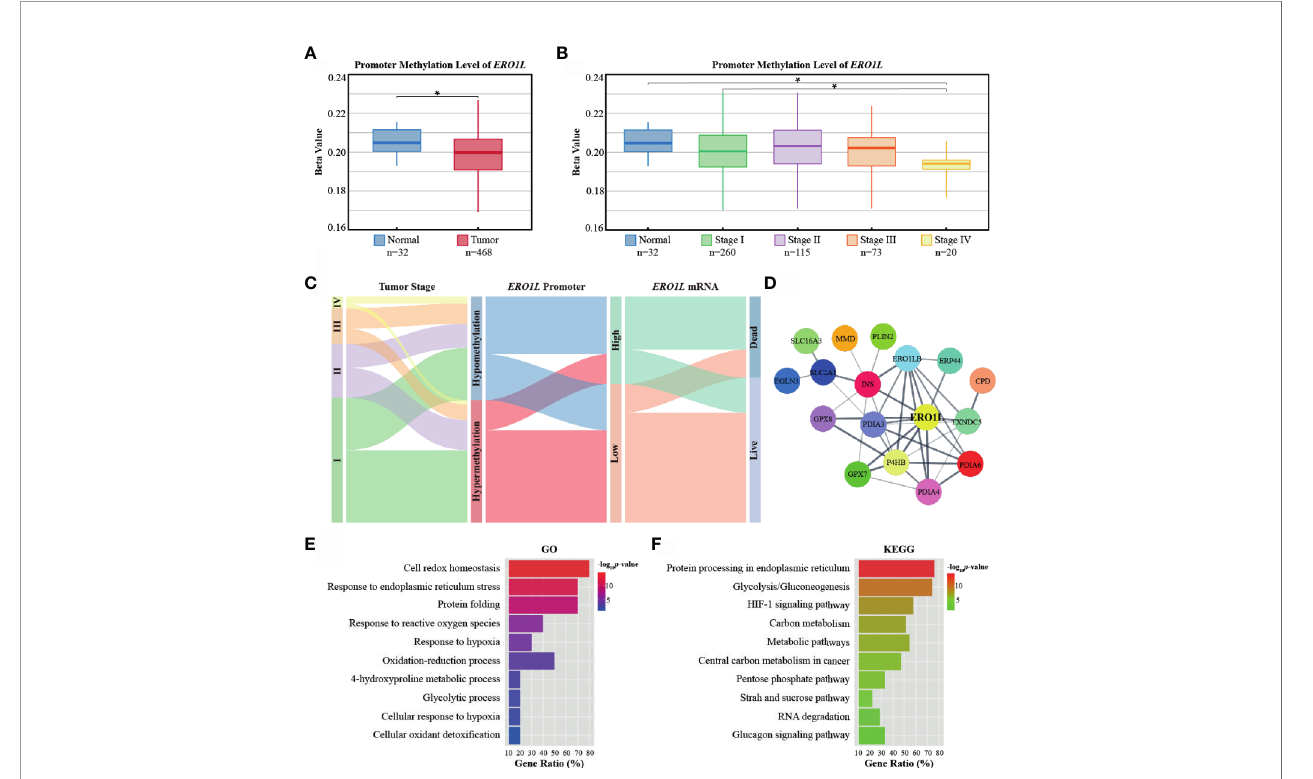
FIGURE 3 | Promoter methylation of ERO1L and functional annotation of the ERO1L co-expression module. (A, B) Analysis of ERO1L methylation in the TCGA database. Promoter methylation levels of ERO1L in tumor and normal tissues (A) according to tumor stage (B) . (C) Path analysis in patients with LUAD across tumor stage, promoter methylation, mRNA expression, and survival status. The line represents the group; the width of the lines represents the number of patients transferred from one state to another (n=468). (D) PPI networks of the ERO1L co-expression module. (E, F) Functional annotation and pathway enrichment of the ERO1L co-expression module. Top 10 terms of GO annotation (E) and KEGG pathway (F) . * p <